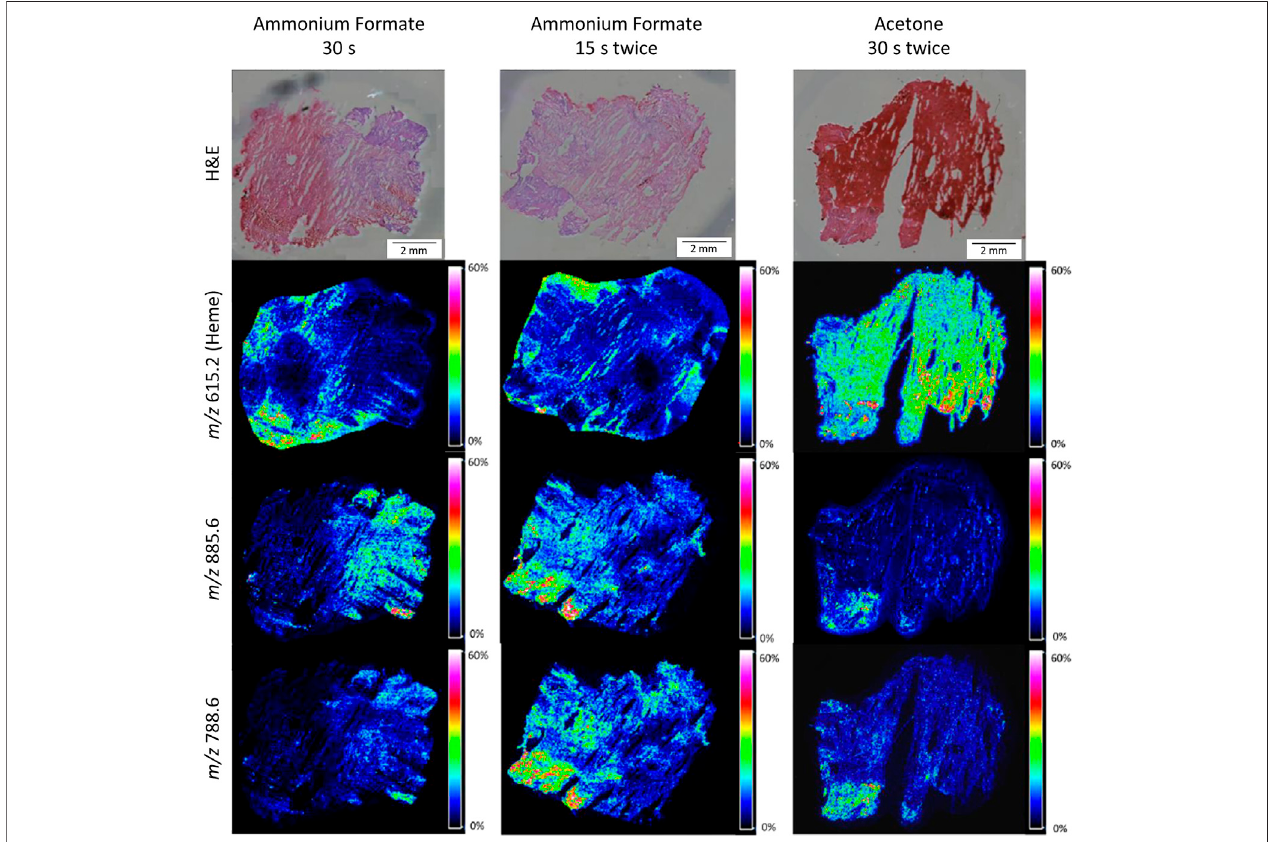
FIGURE3 | H&E stained and MALDI-MSI distribution images for three different washing methods for humanfxh. MALDI-MSI images areshown forthe distribution of heme ( m/z 615.2) and lipids with m/z values 885.6 and 788.6 in negative ion mode for the washing methods: ammonium formate for 30 s (left column), ammonium formate for 15 s twice (middle column), and acetone for 30 s twice (right column). All shown intensities are total ion current (TIC) normalized.